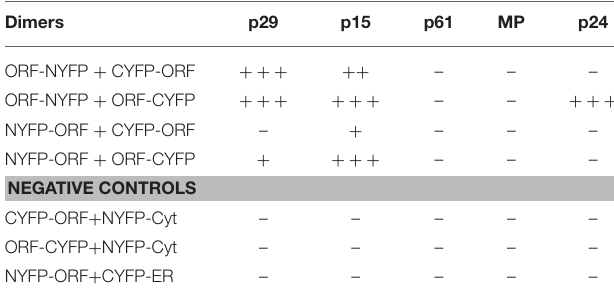
TABLE 1 | Synthesis of all protein pair combinations performed in the BiFC dimerization assay. Dimers